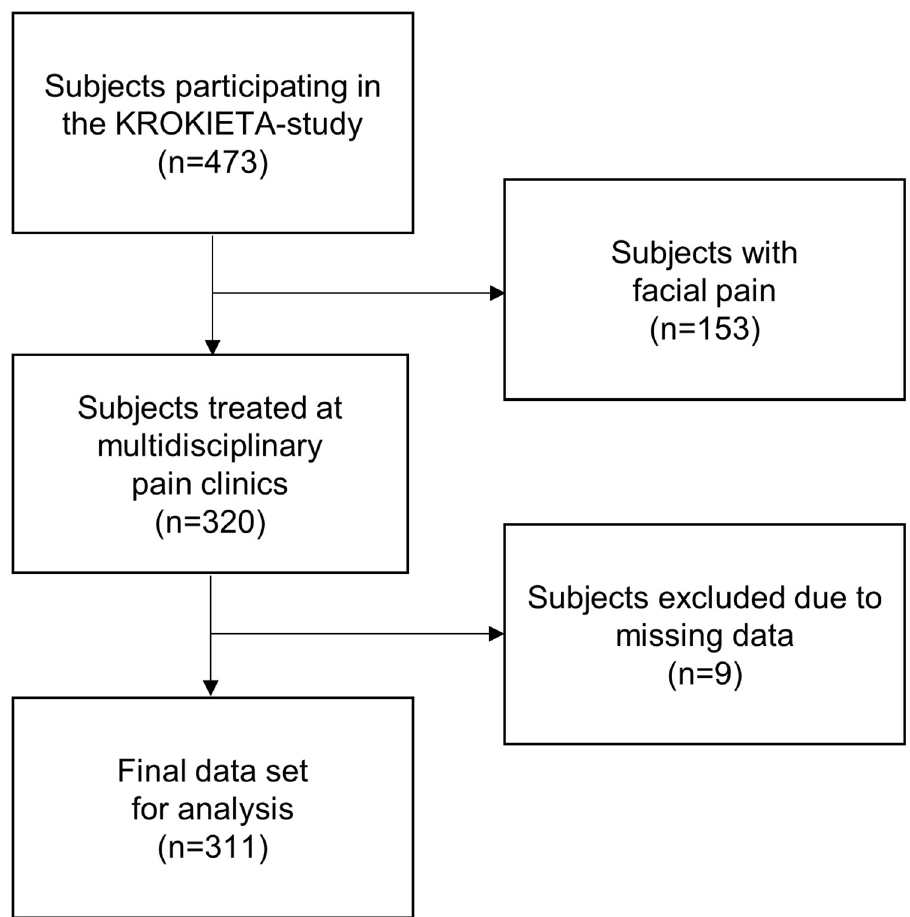
Fig 1. Formation of the study data set. Approximately half of the invited patients declined to participate in the study.